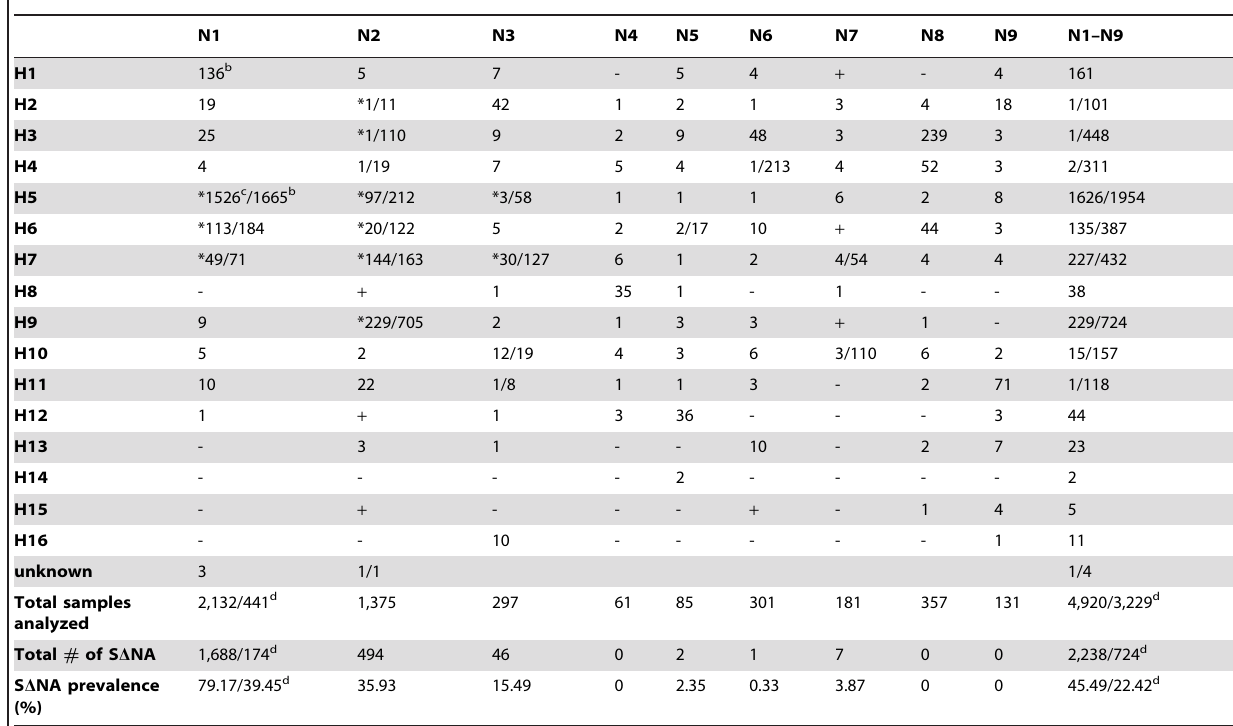
Table 1. Occurrence of NA stalk deletions (S D NA) among all reported avian influenza HA-NA a subtypes.